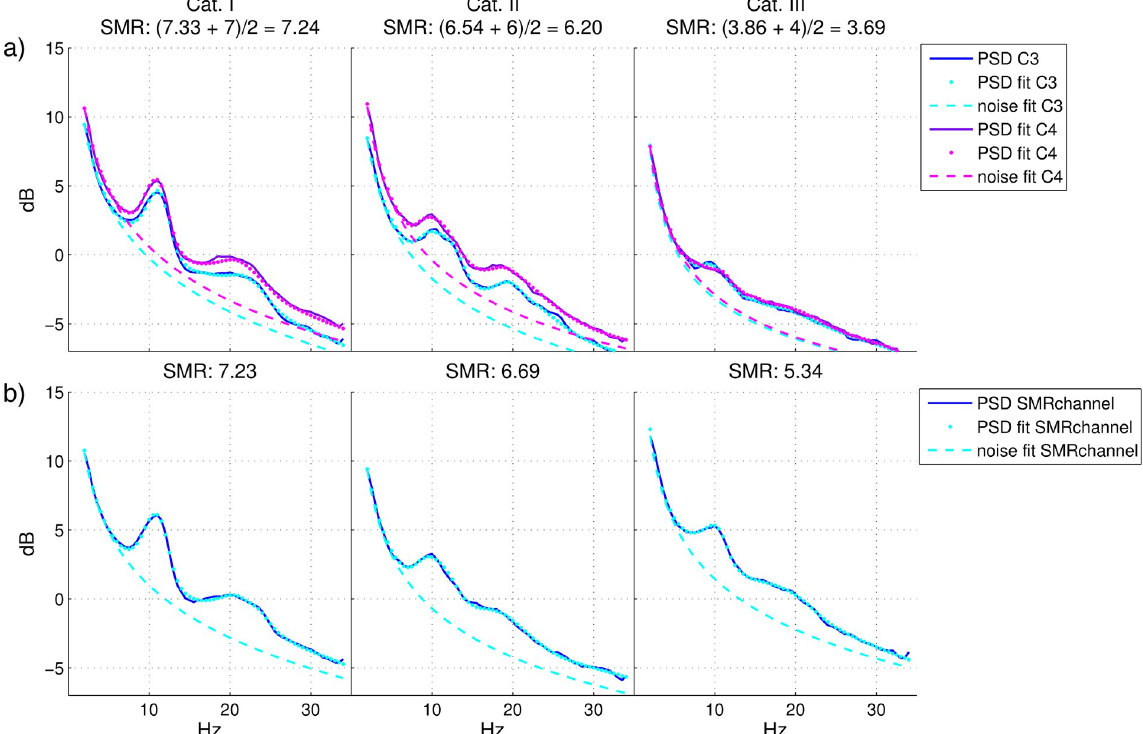
Fig 11. Spectrum at rest and PSD fit. Spectrum at rest (PSD, solid line), model of the PSD (dot line) and model of the noise (dashed line) averaged across users belonging to the same category. From left to right, Cat. I, Cat. II and Cat. III. Panel a): Laplacian derivation of C3 (PSD in blue, PSD fit and noise fit in cyan) and C4 (PSD in purple, PSD fit and noise fit in magenta). In the title, the mean SMR-strength values (the first one is for C3, the second one is for C4) and the SMR-predictor value are reported, calculated separately for each user and channel and then averaged. Panel b): Laplacian derivation of the SMR-channel , which is